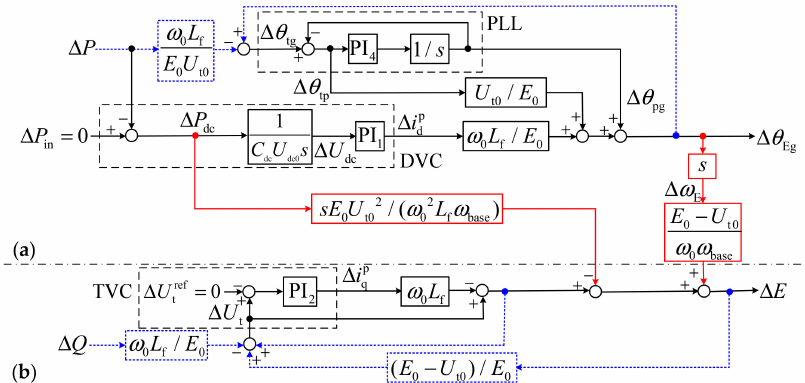
Figure 8. Replacing the variation of terminal voltage U t e j θ t in Figure 7 with the dynamics of powers P , Q, and internal voltage Ee j θ E . ( a ) Phase dynamics of VSC’s internal voltage. ( b ) Amplitude dynamics of VSC’s internal